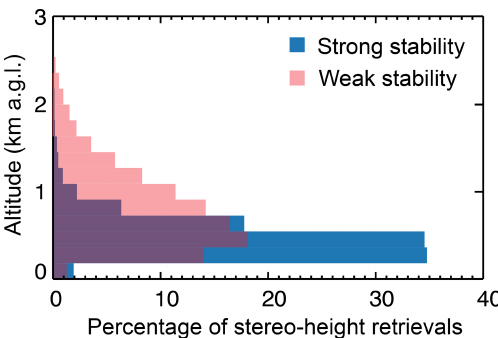
Figure 4. Vertical distribution of MISR stereo-height retrievals for all the plumes analysed, under strong (blue) and weak (red) atmo- spheric stability